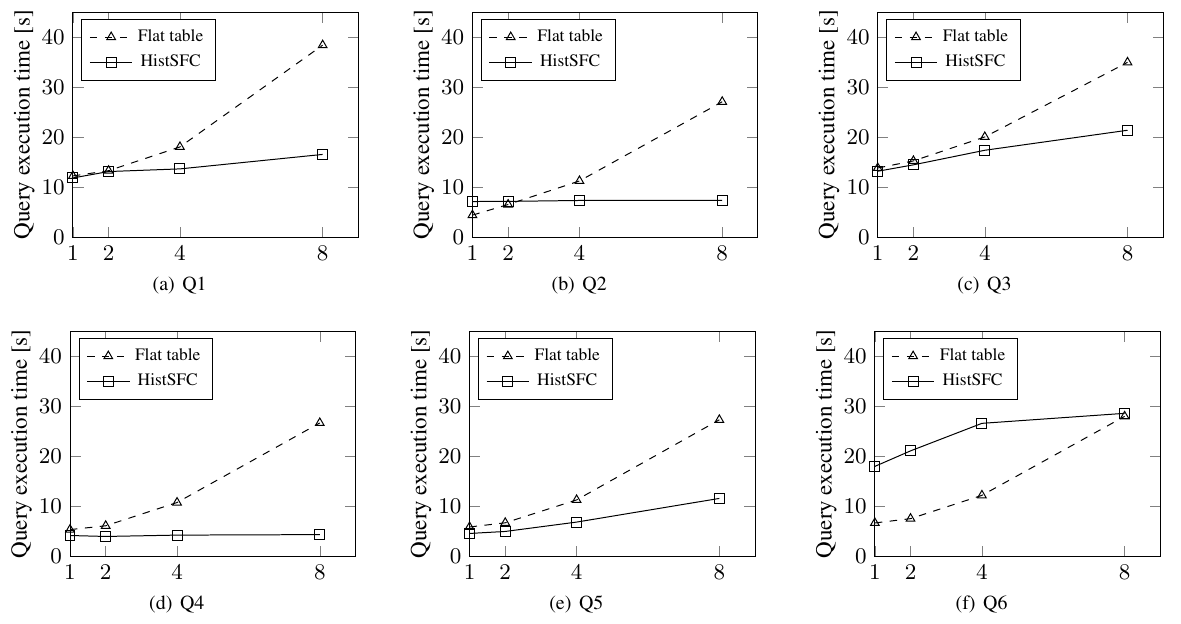
Figure 10. Performance of querying, where X axis represents the number of cases included in the specific data